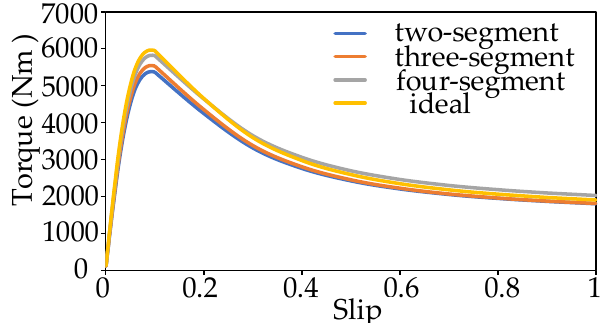
Figure 13. Electromagnetic torques of ECCs with different Halbach magnetic arrays.